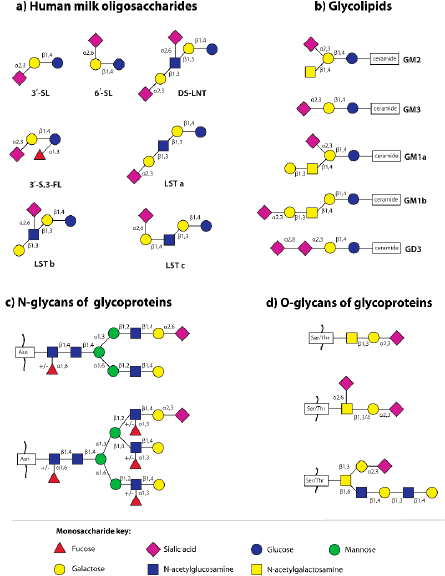
Figure 2. The main sialylated structures of human milk oligosaccharides and glycoconjugates (glycoproteins and glycolipids) [35,41,43,44]. ( a ) Human milk oligosaccharides: 3 ′ -SL — 3 ′ - sialyllactose; 3 ′ -S,3-FL — 3 ′ -sialyl-3-fucosyllactose; 6 ′ -SL — 6 ′ -sialyllactose; DS-LNT — disialyllacto-